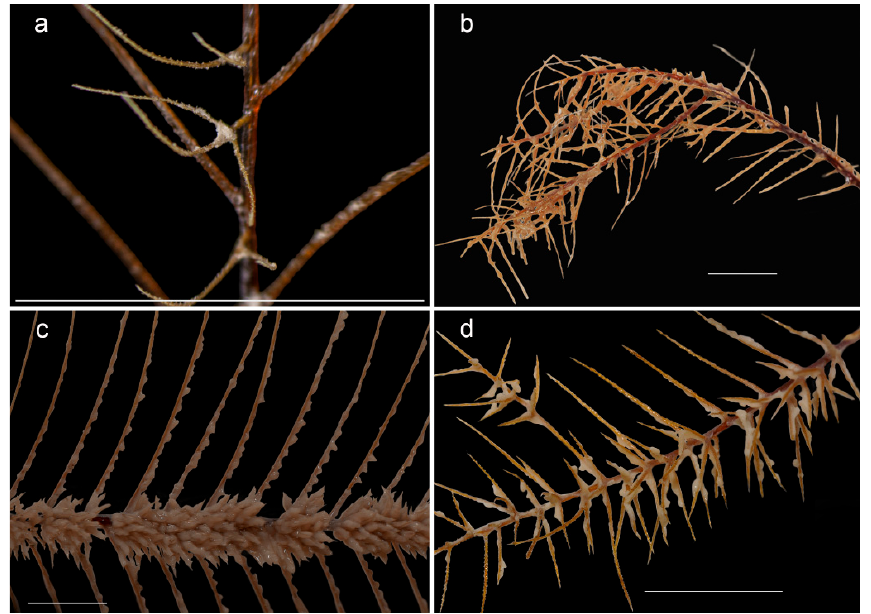
Figure 3. Close-ups of select genera of the family Cladopathidae: ( a ) Abyssopathes lyriformis Opresko, 2002 (holotype, USNM 83567); ( b ) Sibopathes gephura van Pesch, 1914 (holotype ZMA Coel 3283), ( c ) Heteropathes pacifica (holotype, USNM 1070758), ( d ) Trissopathes pseudotristicha (holotype, RMNH Coel. 32045). Scale 10 mm.